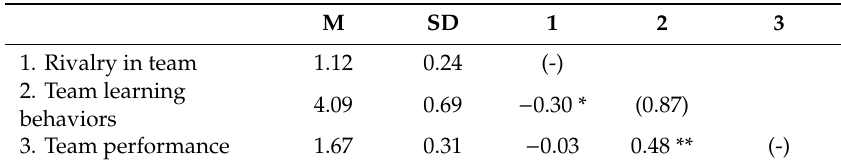
Table 1. Means, standard deviations, and bivariate correlations between all the variables included in the study (N =